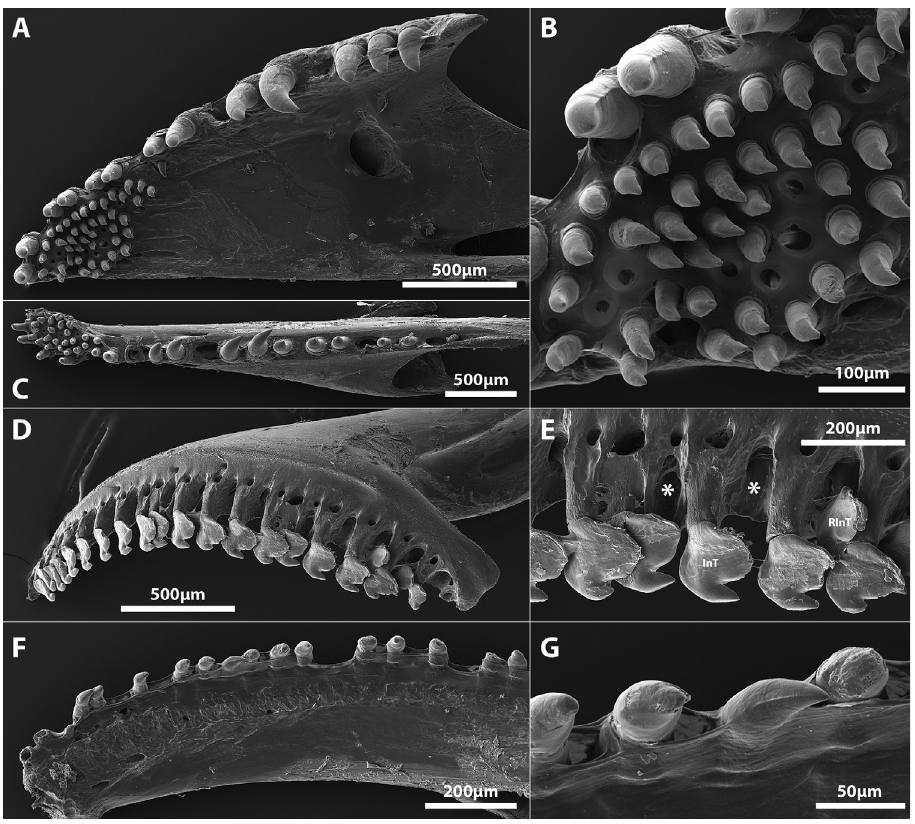
Figure 13. Scanning electron micrographs of the tooth-bearing oral jaw bones of Aspasmogaster costata (AMS I.19103-015, 32.0 mm SL) and Lepadichthys coccinotaenia (SAIAB 49396, 31.0 mm SL). A Premax- illa of A. costata , right side in ventral view (image reversed) B Close up of lingual toothpatch on premaxilla of A. costata shown in A C Dentary of A. costata , right side in ventral view (image reversed) D Premaxilla of Lepadichthys coccinotaenia , right side in lateral view (image reversed) E Close up of incisiviform teeth located on posterior part of premaxilla of L. coccinotaenia shown in D Asterisks (*) highlight locations of crypts associated with dislodged replacement teeth F Dentary of Lepadichthys coccinotaenia , right side in medial view G Close up of conical teeth located along midregion of dentary of L. coccinotaenia shown in F Abbreviations: InT, incisiviform tooth; RInT, replacement incisiviform